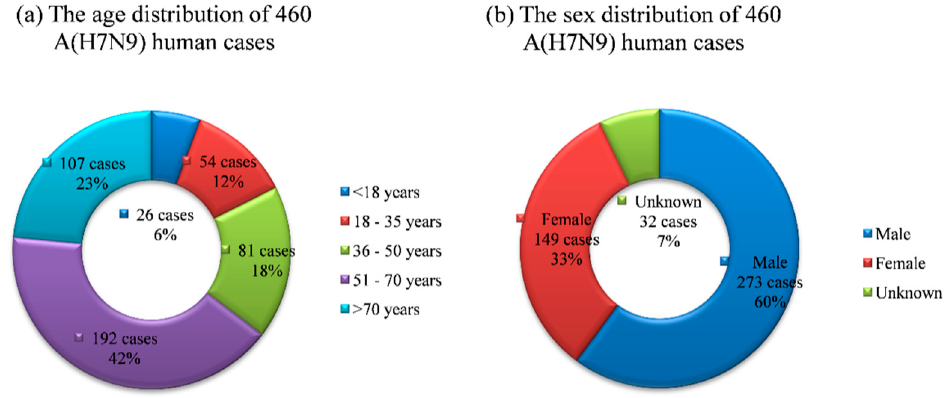
Figure 2. The age and sex distribution of 460 influenza A(H7N9) human cases reported in China during 2013 and 2014.